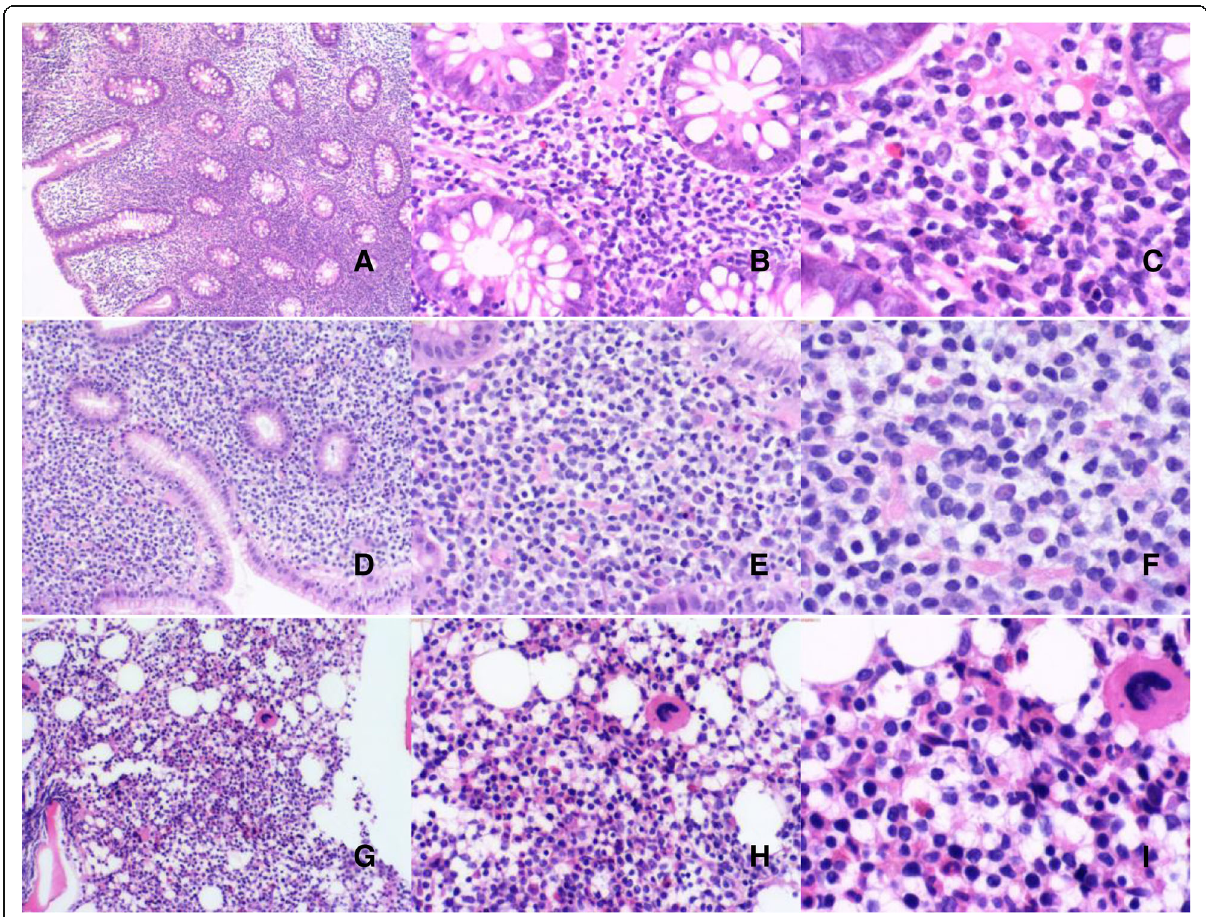
Fig. 2 The biopsies (2017) from colon ( a,b ) and stomach ( c,d ) showed small lymphocytes with scant pale cytoplasm diffuse by infiltrating the lamina propria without cryptal destruction ( e,f ). The lymphoid cells are small and monomorphic with pale cytoplasm. Bone marrow ( g-i ) biopsy specimen showed similar patchy or interstitial infiltrate of small lymphocytes. Ileal, stomach and colon biopsies in 2015 showed similar non-destructive small lymphoid